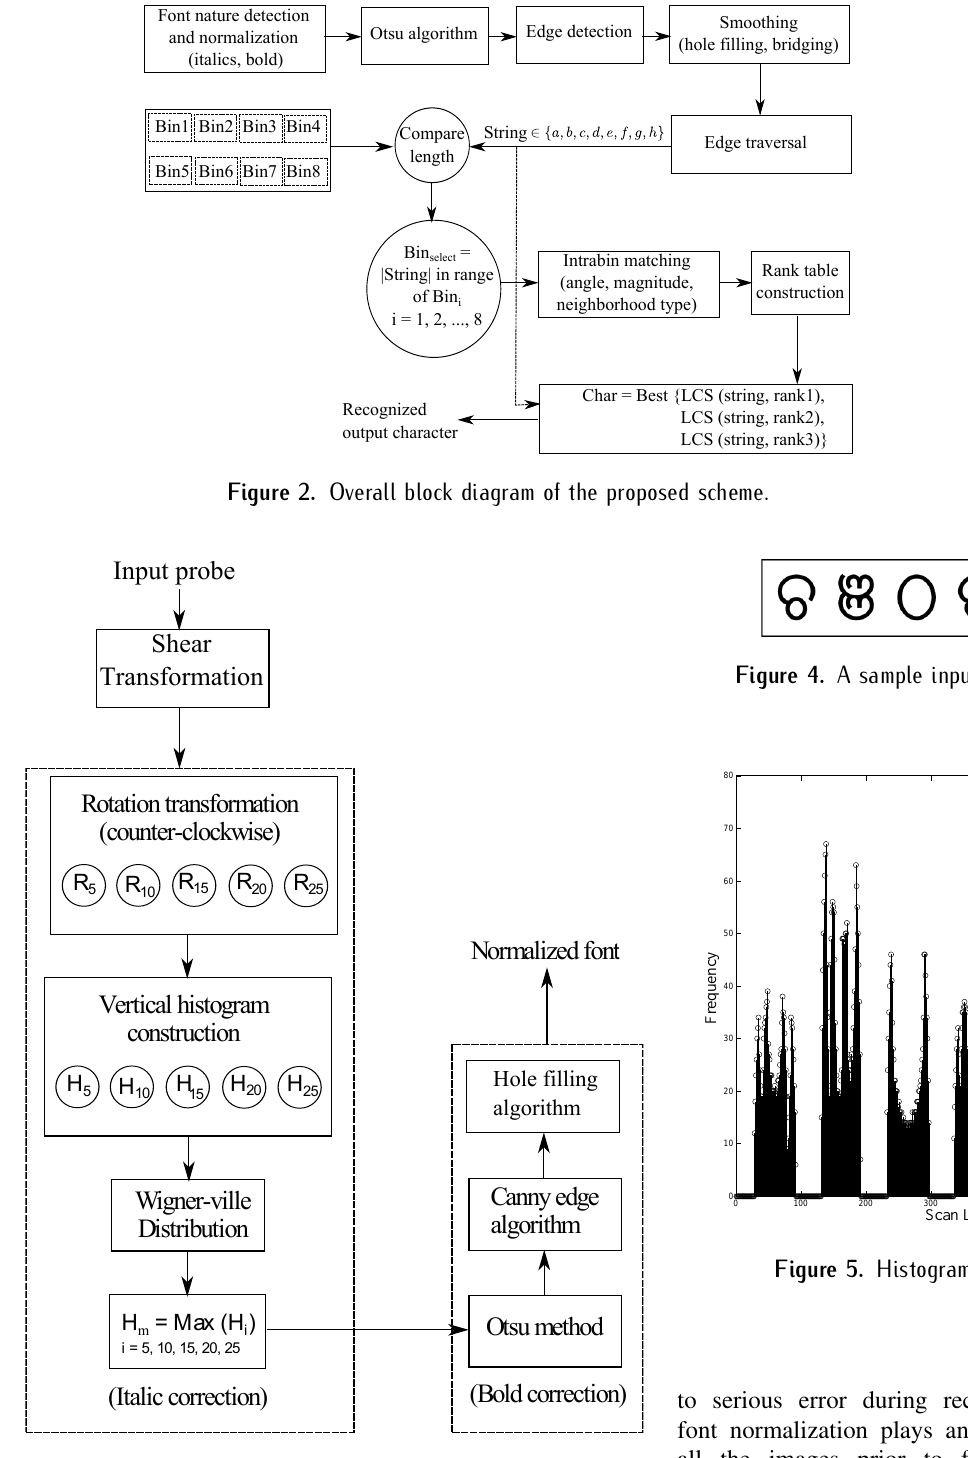
Figure 3. Overall block diagram of the preprocessing steps.